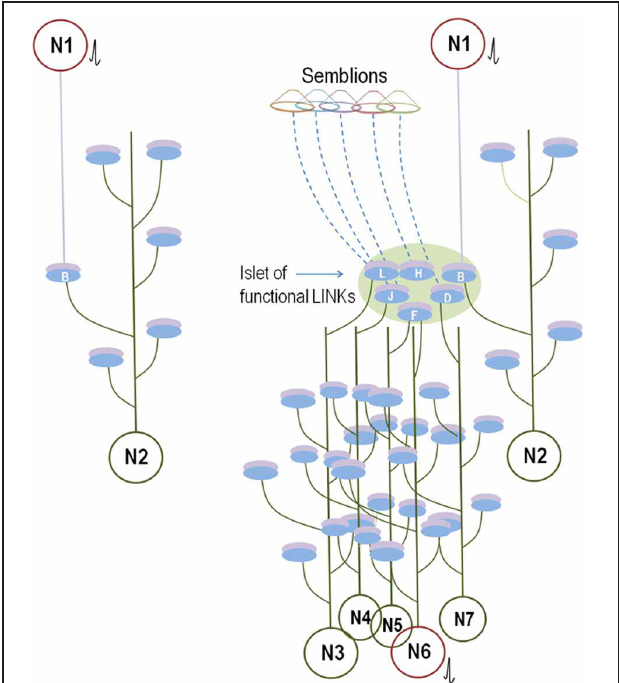
FIGURE 8 | Comparison between the known anatomical circuitry and the inter-postsynaptic functional LINK-mediated wiring. Left panel: Synaptically connected conventional neuronal circuit diagram. There is one synaptic connection between neurons N1 and N2. The activation of neuron N1 induces an EPSP at postsynaptic membrane B. Provided neuron N2 is simultaneously receiving EPSPs from other neurons, the sum of which is just one EPSP short for spatial summation to trigger an action potential, then the EPSP arriving at postsynapse B from the activation of neuron N1 will lead to the firing of neuron N2. The contribution of the EPSP from the activation of Neuron N1 toward the temporal summation of EPSPs to elicit an action potential in neuron N2 should also be considered. Otherwise, a single EPSP or a train of few EPSPs reaching at postsynapse B alone may not induce an action potential of neuron N2. Right panel: Wiring diagram based on the present work. The activation of neuron N1 activates the inter-postsynaptic functional LINKs between the postsynapses in the islet of functional LINKs ( Figure 2 , bottom panel ). The re-activation of postsynapse B that belongs to neuron N2 can provide EPSP and enable neuron N2 to fire an action potential similar to the threshold conditions explained for neuron N2 of the conventional wiring diagram (in the left panel ). In addition, EPSPs spread to other hemi-fused postsynapses D, F, H, J, and L (depending on the extent of the spread through the islet) that can reach toward their neuronal somata. According to the supplementary rules, a total of six postsynapses are re-activated here, in comparison to only one by the canonical synaptic transmission ( left panel ). This increases the probability for firing of sub-threshold activated neurons in the next order by bringing them toward the threshold for activation. For example, neuron N6 continuously receives ( n − 1) EPSPs, just short of one EPSP toward either spatial or temporal summation to elicit an action potential. Arrival of the n th EPSP from the islet of functionally LINKed postsynapses enables neuron N6 to cross the threshold to elicit an action potential (shown in red). If neuron N6 is a motor neuron, it can evoke motor activity concurrent with the re-activation of the functionally LINKed postsynapses B, D, F, H, J, and L. Activity through these LINKed postsynapses will also evoke semblions for the formation of internal sensations provided these are located at regions of oscillatory neuronal activity. All the neurons in red receive sufficient summated EPSPs and fire action